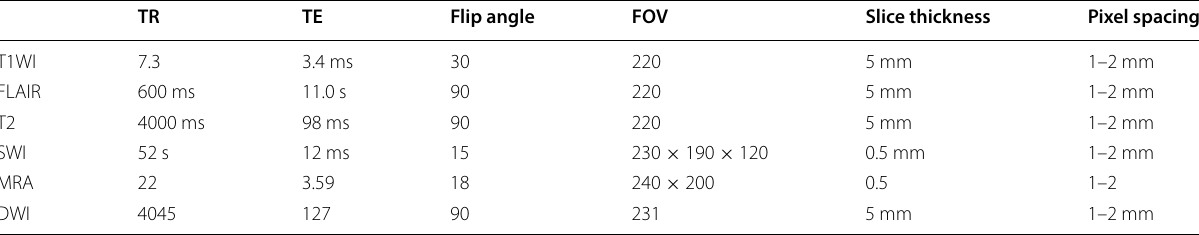
Table 1 Technique for MRI sequences, DWI and